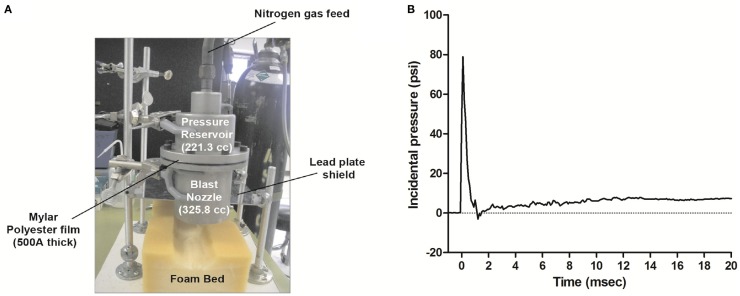
Blast wave generation and detection. Blast waves were produced using the generator apparatus pictured in (A). The blast generator nozzle was positioned over the head of the animal, and each rat was exposed to a single overpressure wave with the body shielded by a lead plate. Pressure values were recorded using a piezoelectric transducer (PCB Piezotronics Inc., NY, USA) every 0.1 ms. (B) Representative blast wave from a single blast illustrating an incident peak pressure value of 80 psi (rise time of 0.2 ms), duration of 1.47 ms, a positive impulse (AUC) of 31.5 psi/ms, and a negative pressure of −3 psi at 1.2 ms. The mechanics of the overpressure wave simulation by the Conwep software may be found in Table S1 in Supplementary Material.